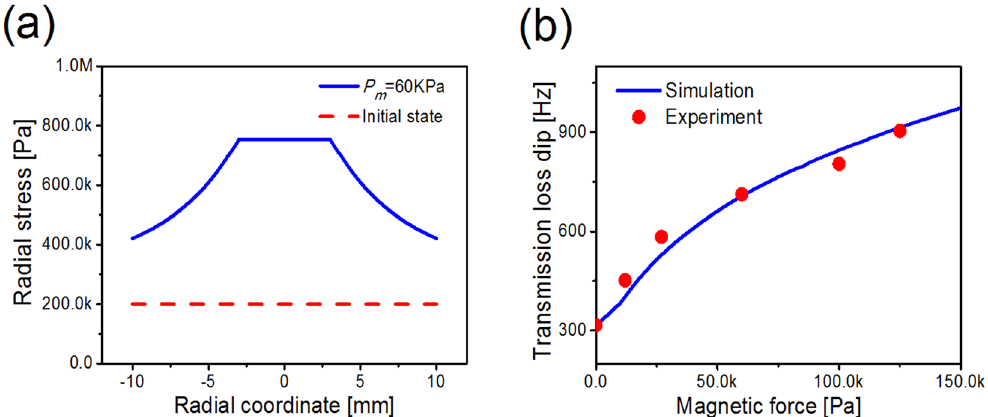
Figure 2. ( a ) The numerical results of radial stress distribution with/without out-of-plane magnetic force. The initial state is uniform stress as shown in red dash curve, and blue solid curve denotes simulation result of Pm = 60 KPa. ( b ) The influence of out-of-plane magnetic force on the transmission loss dip. The experimental results are shown in red circles, and blue solid curve denotes simulation